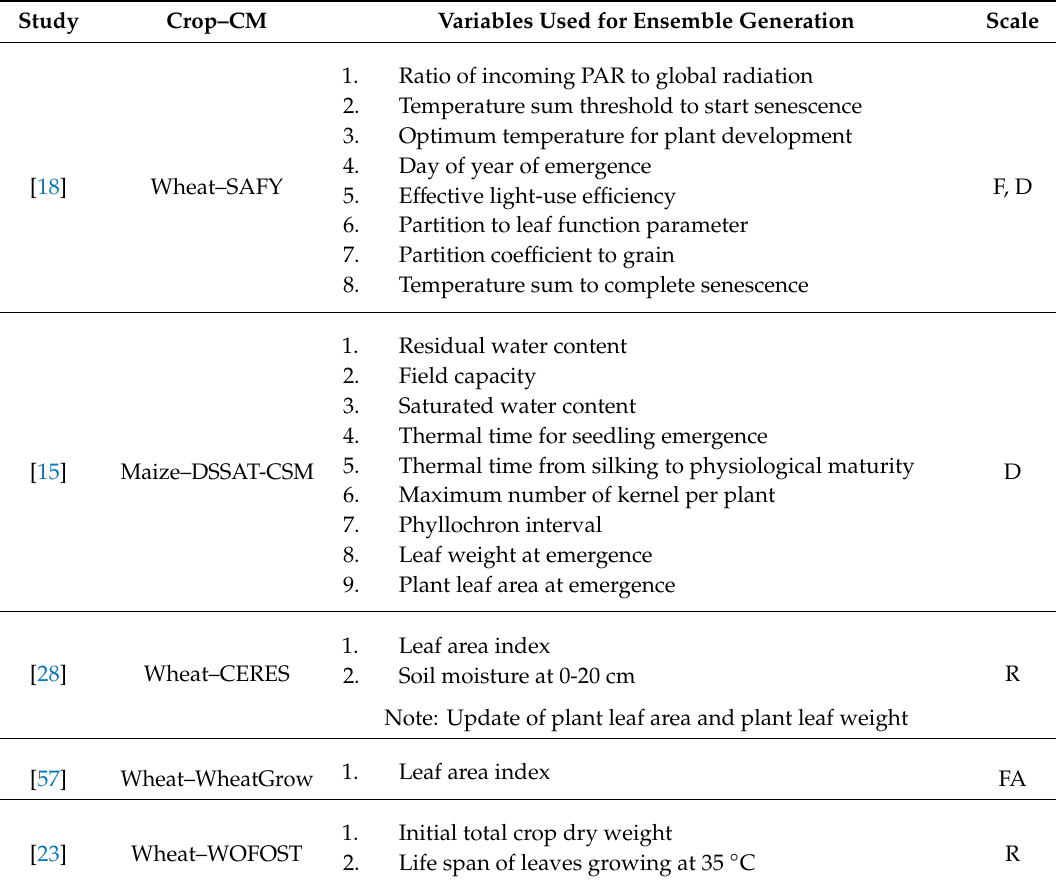
Table A1. List of LAI data assimilation studies with ensemble generation variables employed and respective scale considered. CM = Crop Model, F = Field, FA = Farm, D = District, R = Region.